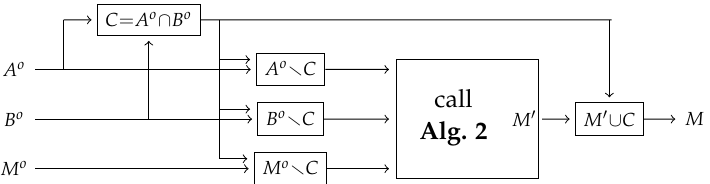
Figure 6. Outline of Algorithm 1. Given the input ( A o , B o , M o ) , extract the common part C of A o and B o , and call Algorithm 2 with the reduced sets. Finally, add C to the returned M (cid:48) to generate the output M